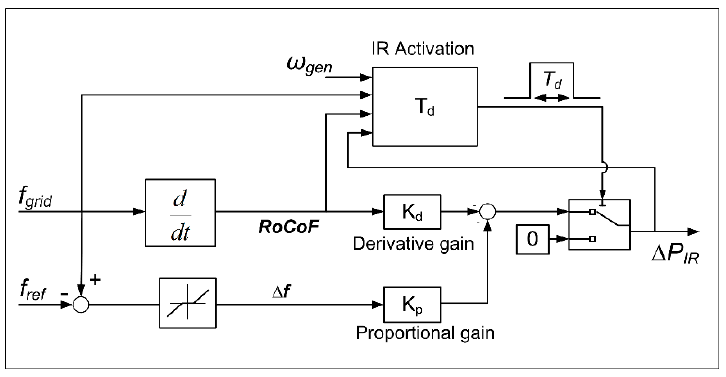
Figure 3. Illustration of control scheme for synthetic inertial response of wind power plants.